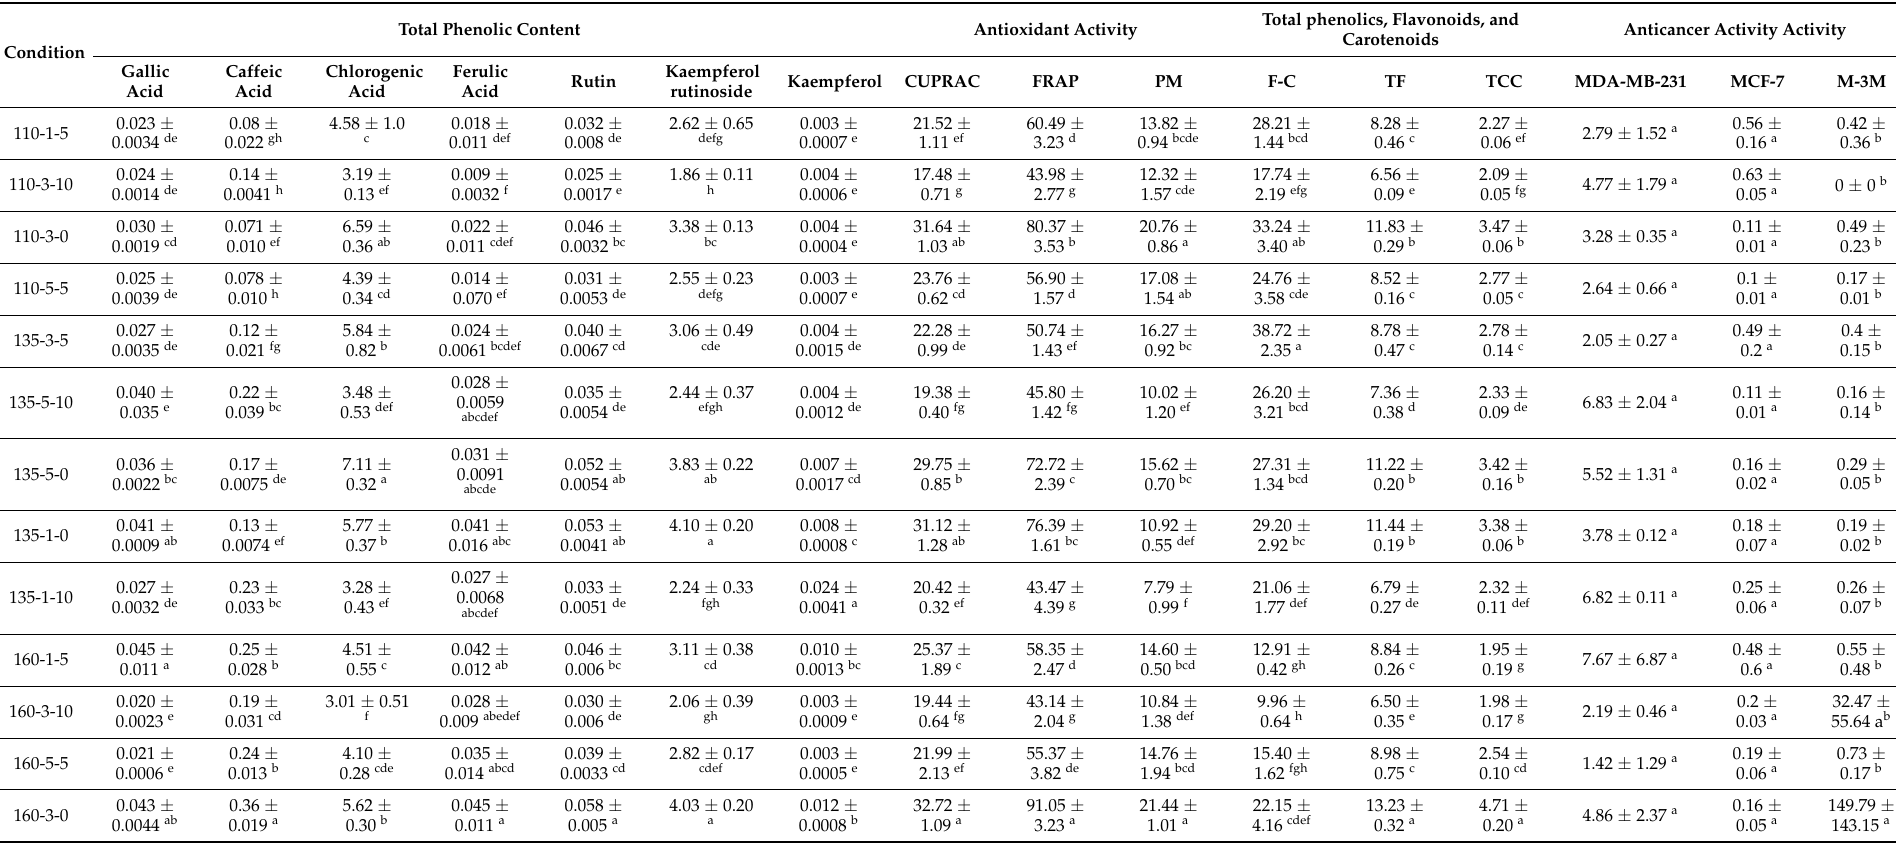
Table 2. Profiles of polyphenol compounds (mg/100 g DW); antioxidant activity (CUPRAC: cupric reducing antioxidant capacity (mg Trolox/g DW), FRAP: